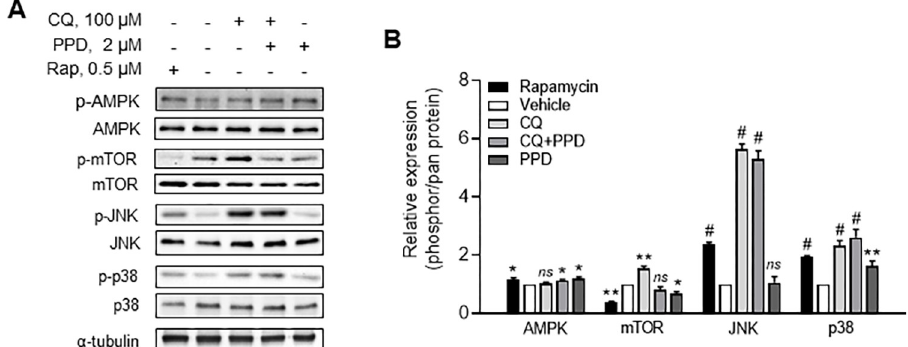
Fig 6. AMP-activated protein kinase (AMPK) and mechanistic target of rapamycin (mTOR) signals are associated with cytoprotective effect of protopanaxadiol (PPD) in chloroquine (CQ)-treated adult retinal pigment epithelial (ARPE)-19 cells. (A) Western blotting (WB) and (B) quantitative analysis of phosphorylated (p)-AMPK, AMPK, p- mTOR, mTOR, p-c-Jun N-terminal kinase (JNK), JNK, p-p38 mitogen-activated protein kinase (MAPK, p-p38), and p38 MAPK (p38) expression in ARPE-19 cells 6 h after treatment with vehicle, 100 μ M CQ, 2 μ M PPD+100 μ M CQ, 2 μ M PPD, and 0.5 μ M rapamycin (Rap). Data are means ± standard deviation (SD), n = 3; ns , � P < 0.05, �� P < 0.01, and # P < 0.001 vs each control.